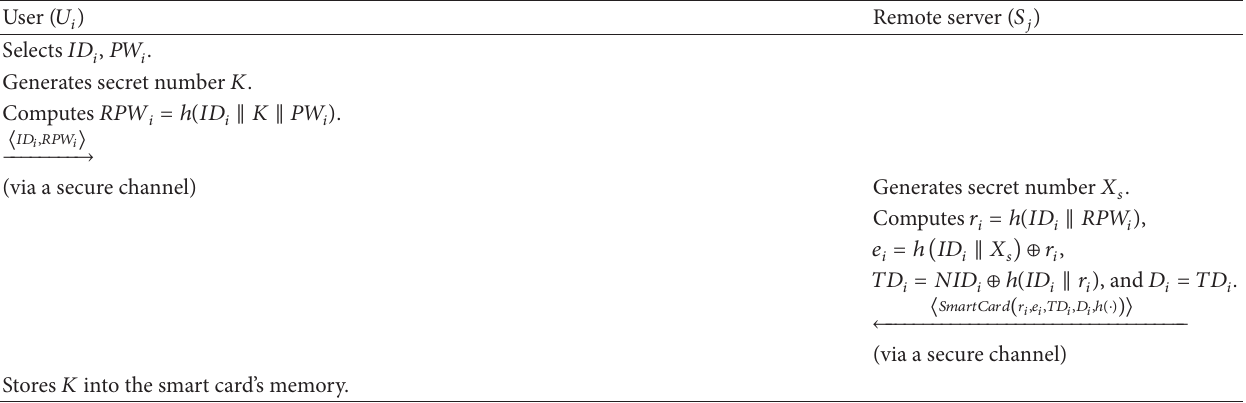
Table 1: Summary of the registration phase of our scheme.